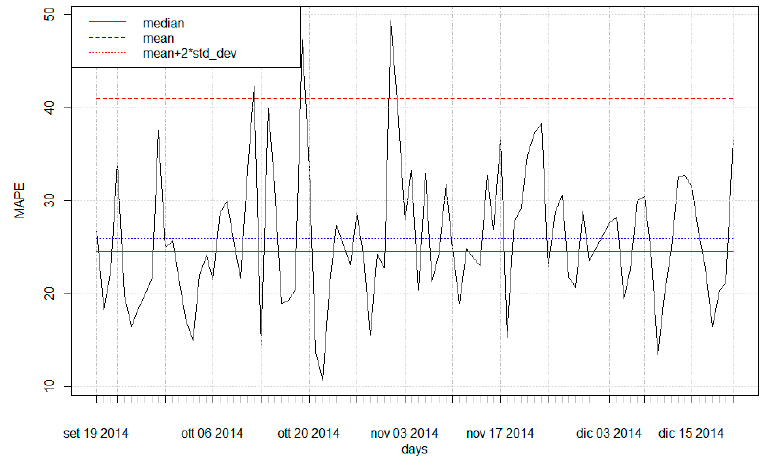
Figure 15. MAPE over the observation period for the non-residential “mixed” case (Case 3).